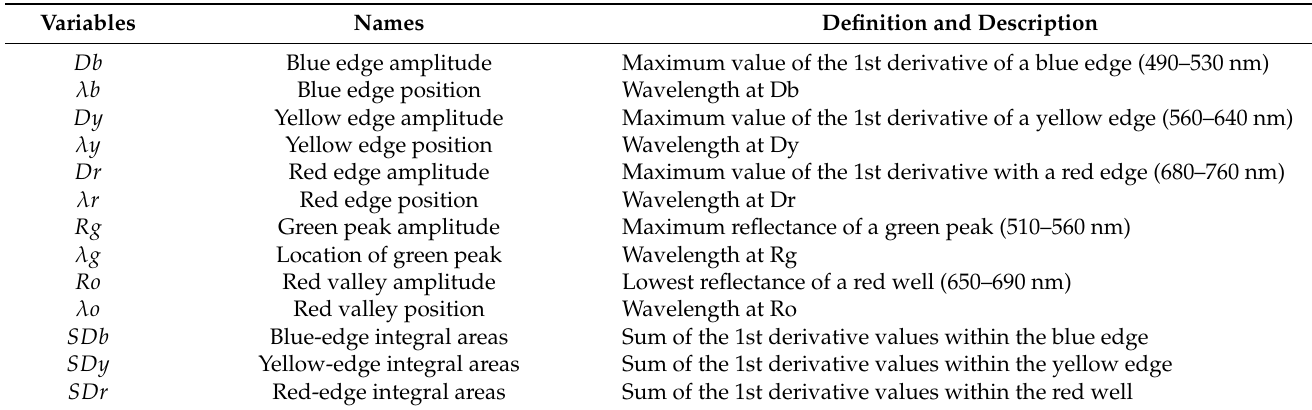
Table 3. Definition and description of waveband position parameters.